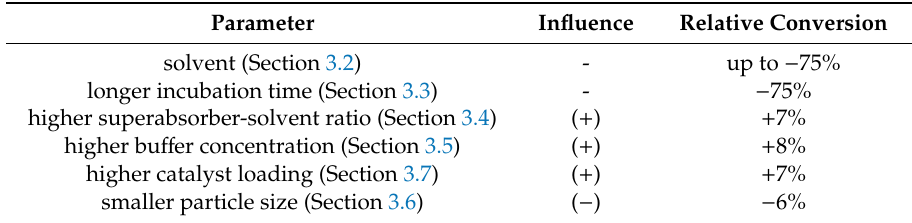
Table 4. Influence of di ff erent parameters on the reduction of acetophenone ( 1 ) in a biphasic superabsorber / MTBE system, considering conversions to alcohol ( R )- 2 after approximately 24 h in comparison to an initial standard experiment (Section 3.1). Legend: − negative impact, + positive impact, parentheses indicate small